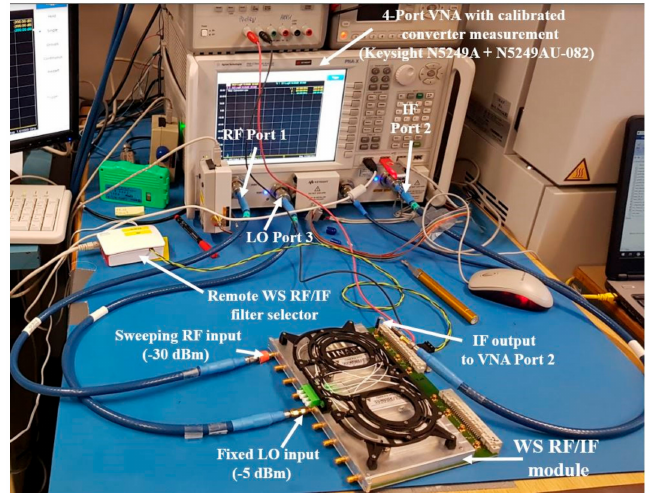
Figure 17. Testing of one of the WS RF / IF boards (without the IFoF links). The RF port of the vector network analyzer (VNA) is connected to channel 1 of the board. The IF signal is extracted from the board micro coaxial connector (MCX) corresponding to channel 1 RF